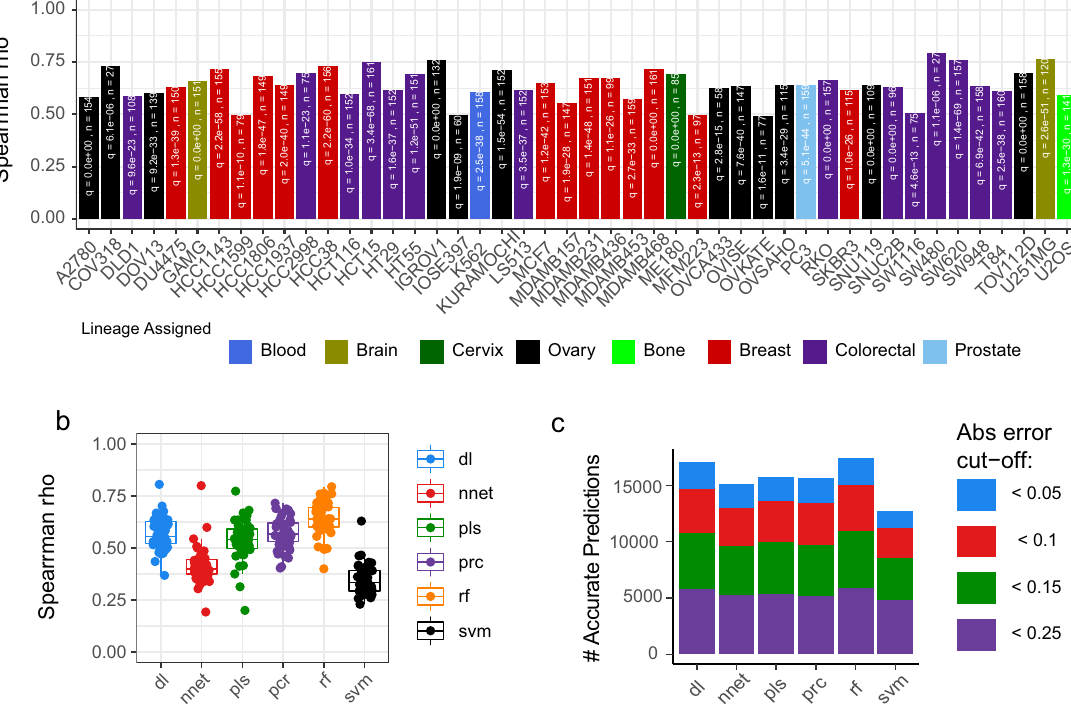
Fig. 6 Accuracy assessment of DRUML to rank drugs based on ef fi cacy using independent proteomics datasets derived from 47 tumor models and 8 pathologies. DRUML was used to predict drug responses for 47 cell lines using proteomic data obtained from 12 different laboratories and compiled by Jarnuczak et al. (Vizcaino lab, PRIDE PXD013455). Statistical signi fi cance of predictions was measured using Spearman ’ s rank correlation coef fi cient and Rho values are shown in fi gures ( a and b ). a Comparison of measured vs predicted drug responses within cellular models using the random forest method. Samples are colored by sample origin. b Distribution of Spearman rho correlation values between predicted and actual drug responses for all samples separated by ML learning algorithm. This boxplot has median centers, interquartile box boundaries and range upper and lower hinges. c Comparisons of the proportion of accurate predictions at 0.05, 0.1, 0.15 and 0.25 error cut-offs returned by the different ML methods. Learning algorithms were random forest (rf), cubist, bayesian estimation of generalized linear models (bglm), partial least squares (pls), principal component regression (pcr), support vector machine (svm), deep learning (dl) and neural network